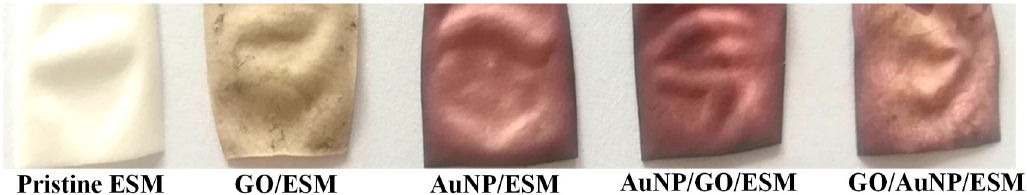
Figure 1. Optical image of eggshell membrane (ESM) samples.